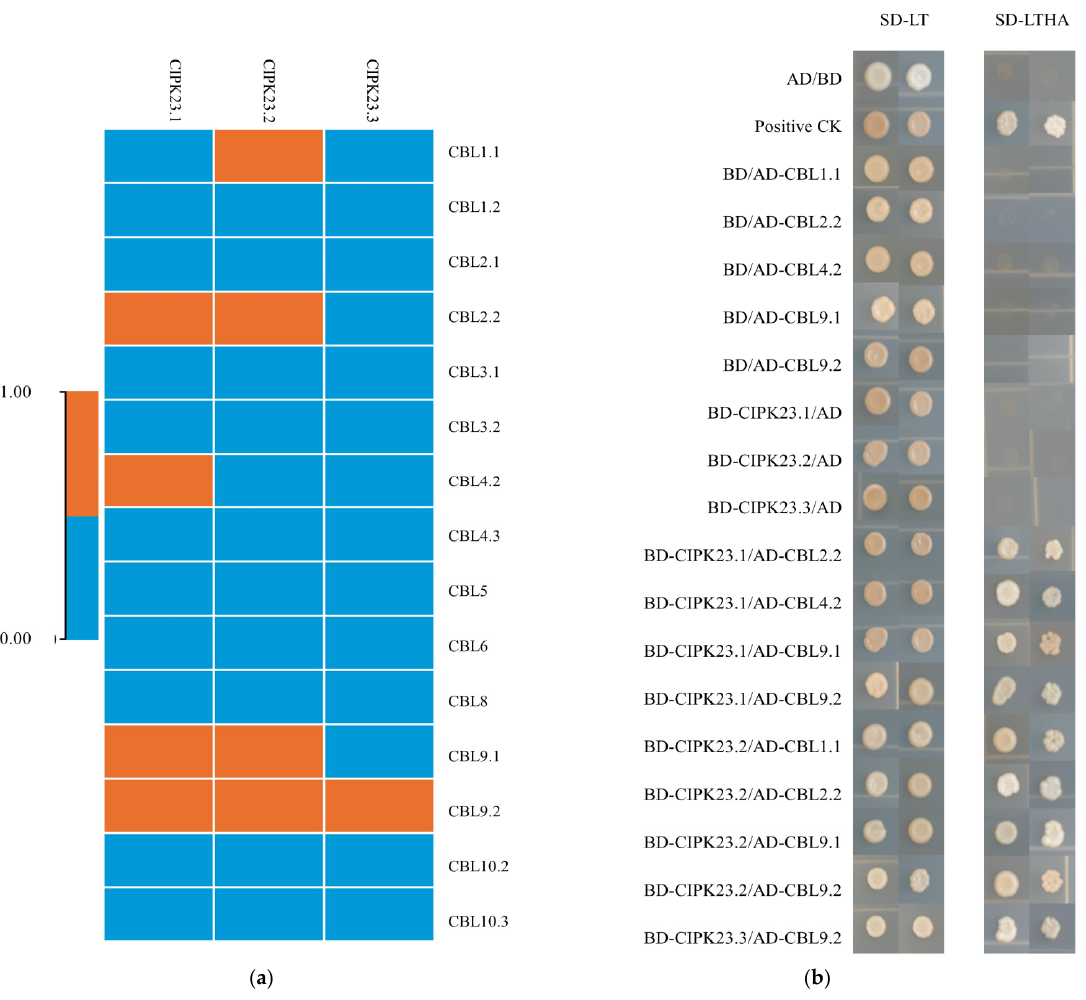
Figure 7. Interaction analysis between the BraCIPK23 repeat gene and BraCBLs protein. ( a ) Heat map summarizing yeast two-hybrid (Y2H) results for all interactions between Chinese Cabbage CBL and CIPK proteins. Orange means interaction, blue means no interaction. ( b ) Yeast two-hybrid experiment showed the interaction between BraCIPK23.1, -23.2, -23.3 and 15 BraCBLs, AD + BD represented negative control, and positive CK represented positive control check.